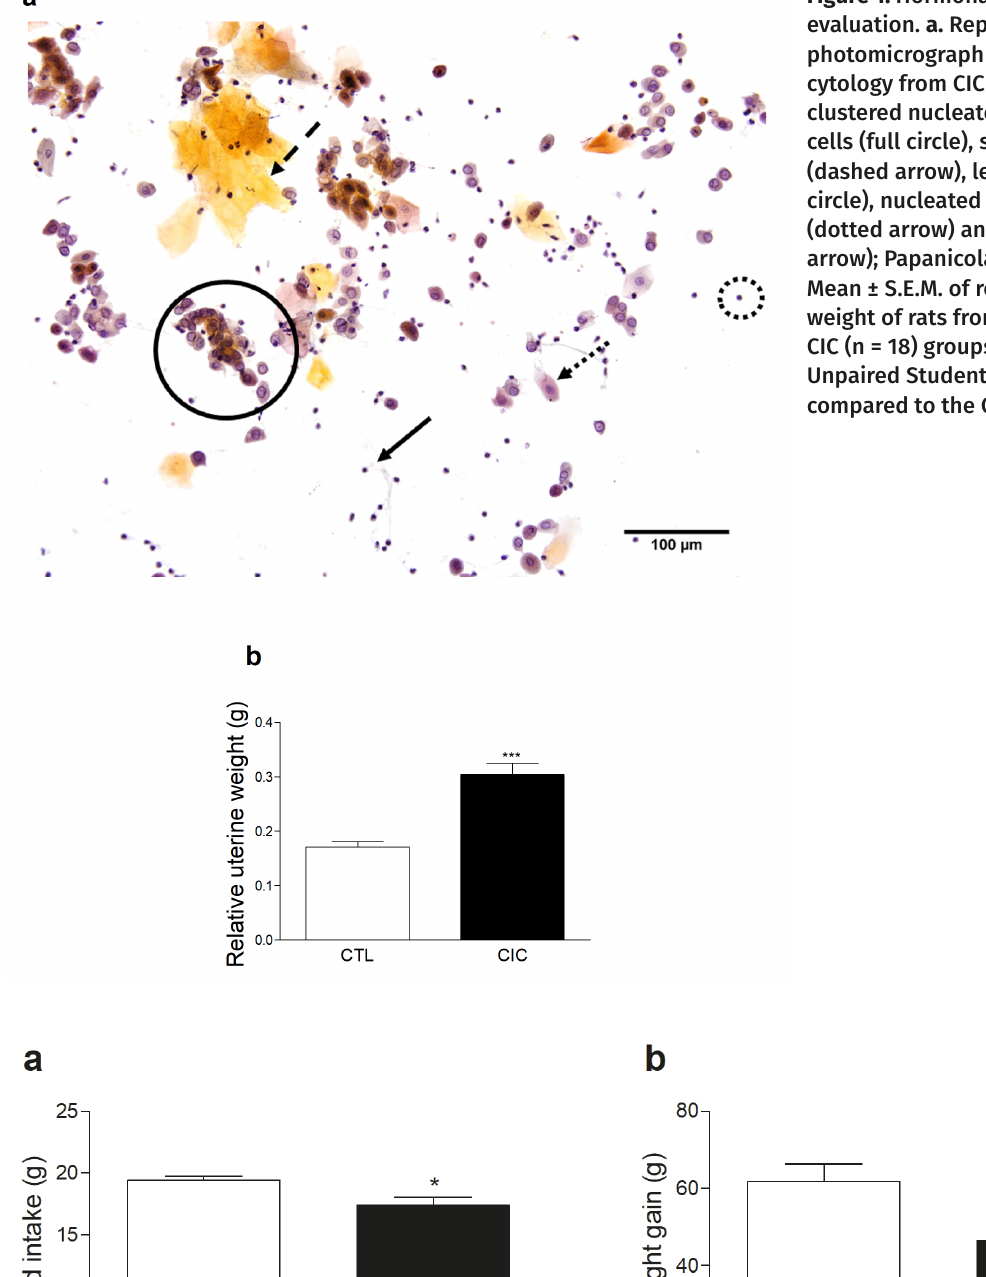
Figure 1. Hormonal status evaluation. a. Representative photomicrograph of